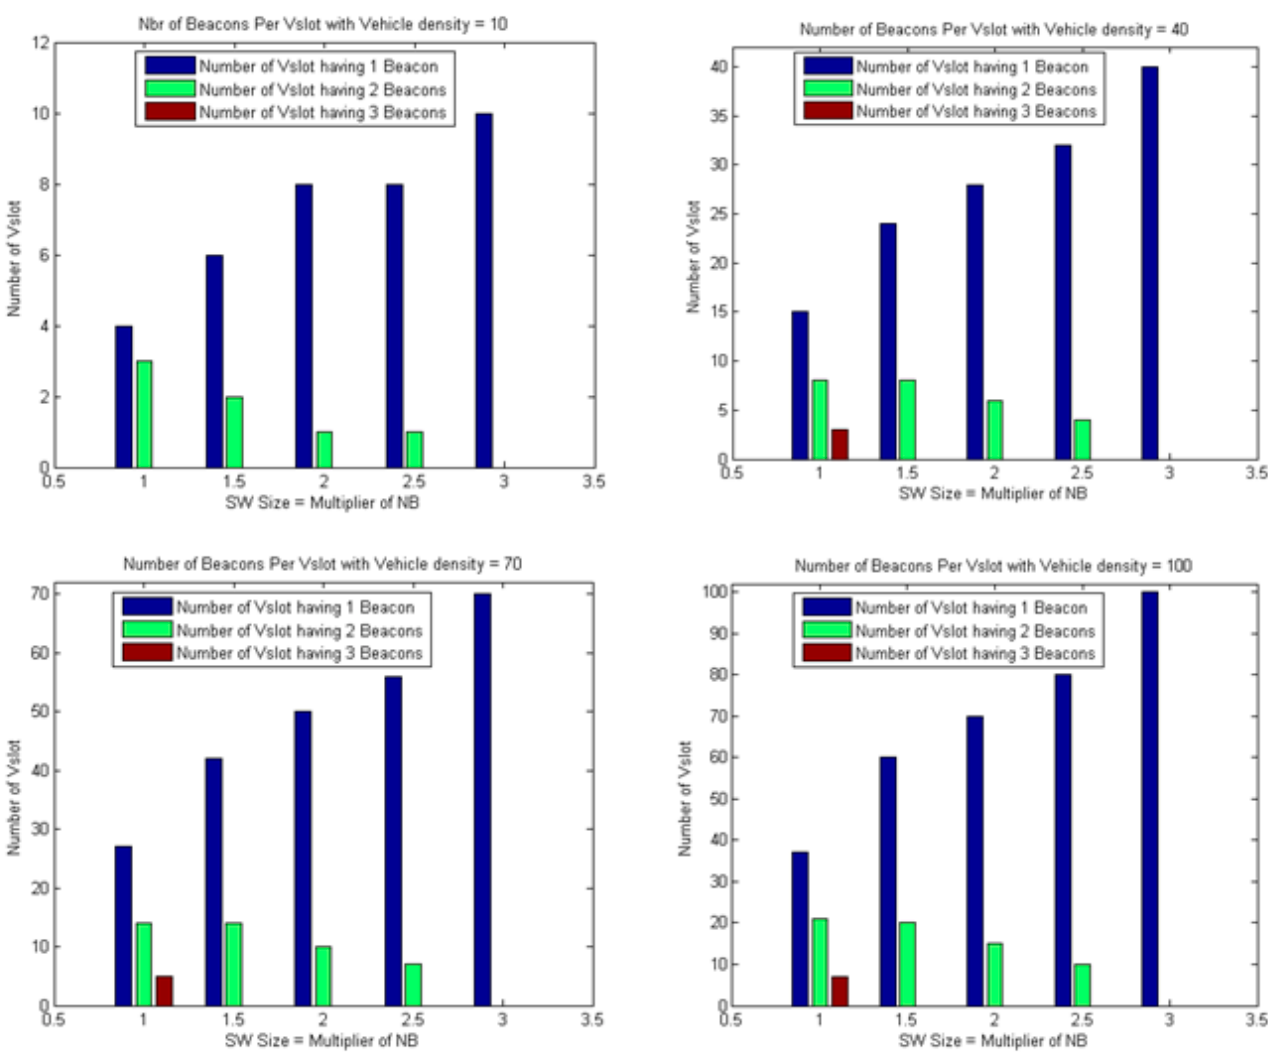
Figure 6. The maximum number of beacons per Vslot, compared to the density of vehicles and the size of the SW.